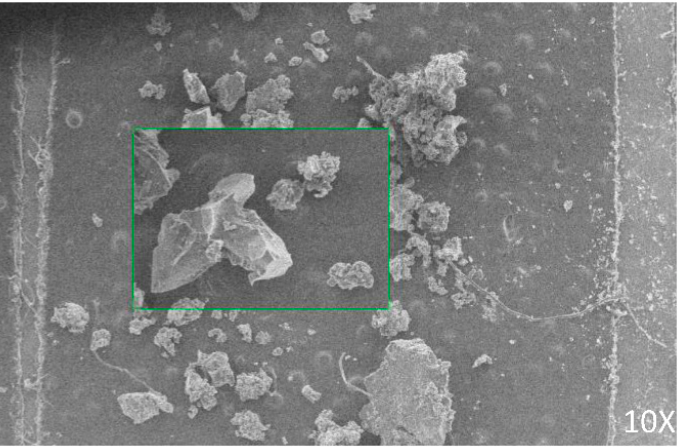
Figure 7. ( a ) Microscopic appearance of ceramsite; ( b ) microscopic appearance of rubber particles.